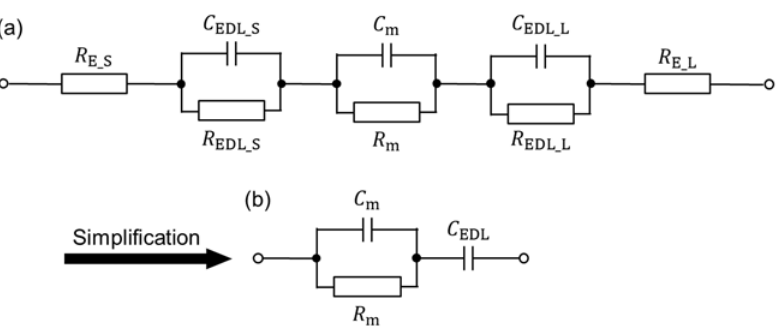
Figure 10. Equivalent circuit of the proposed device. ( a ) Equivalent circuit, considering elements consisting of the device at the measurement frequency. ( b ) Simplified equivalent circuit.